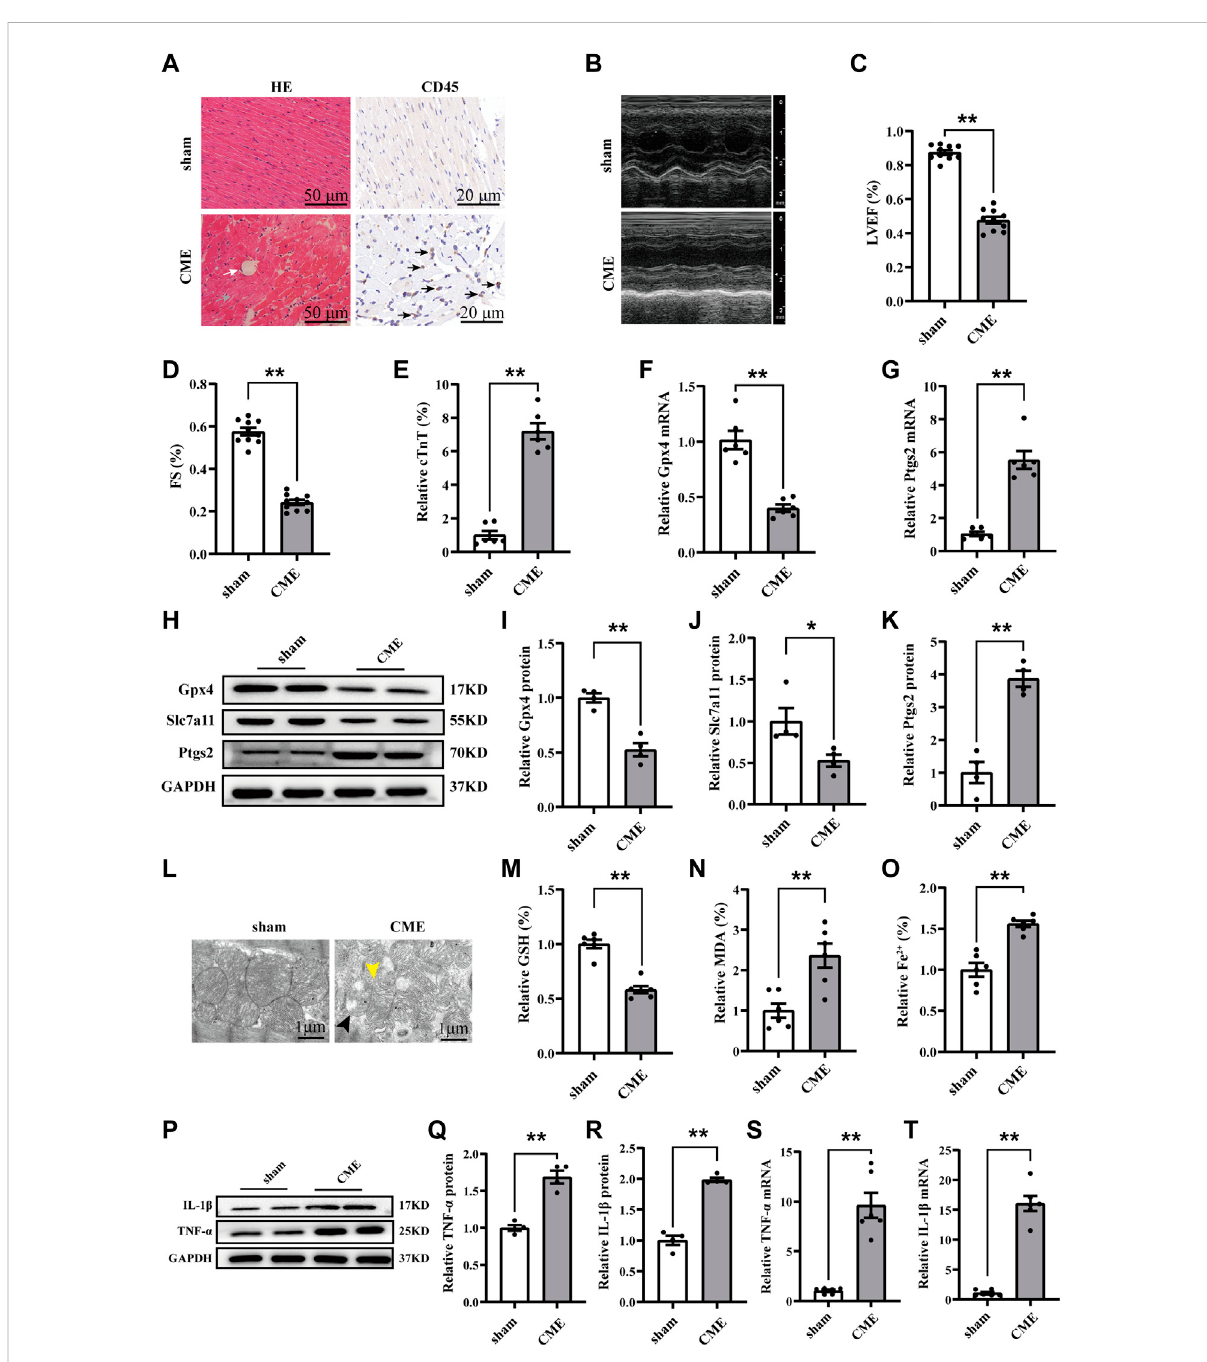
Ferroptosis and in fl ammation involved in CME-induced myocardial injury. (A) Myocardial tissues stained with H&E (scale bar = 50 μ m) and immunohistochemistry (scale bar = 20 μ m). The white arrow indicates microspheres. The gray arrow indicates microinfarcts. The black arrow indicates the in fi ltration of in fl ammatory cells. (B – D) Cardiac LVEF and FS detected by echocardiography ( n = 10). (E) Serum levels of cTnT in the shamandCMEgroup( n =6). (F,G) TheexpressionlevelsofGpx4andPtgs2mRNA( n =6). (H – K) WesternblottinganalysisofGpx4, Slc7a11,and Ptgs2 ( n = 4). (L) Representative images of transmission electron microscopy. The black arrow indicates the reduced or even disappeared mitochondrialcristae.The yellowarrowindicatestheruptureoftheoutermembrane.Scalebar= 1 μ m. (M – O) CardiaclevelsofGSH, Fe 2+ ,andMDA were measured ( n = 6). (P – T) The expression of IL-1 β and TNF- α in mRNA ( n = 6) and protein levels ( n = 4). GAPDH served as an internal control and was performed to quantitatively normalized the protein data. Data are presented as the normalized mean ± SEM (to sham) or mean ± SEM. Values in shams were averaged and normalized to 1 (E – T) . * p < 0.05. ** p < 0.01. CME: coronary microembolization; H&E: hematoxylin and eosin; LVEF: left ventricular ejection fraction; FS: fractional shortening; cTnT: cardiac troponin T; Gpx4: glutathione peroxidase 4; Slc7a11: solute carrier